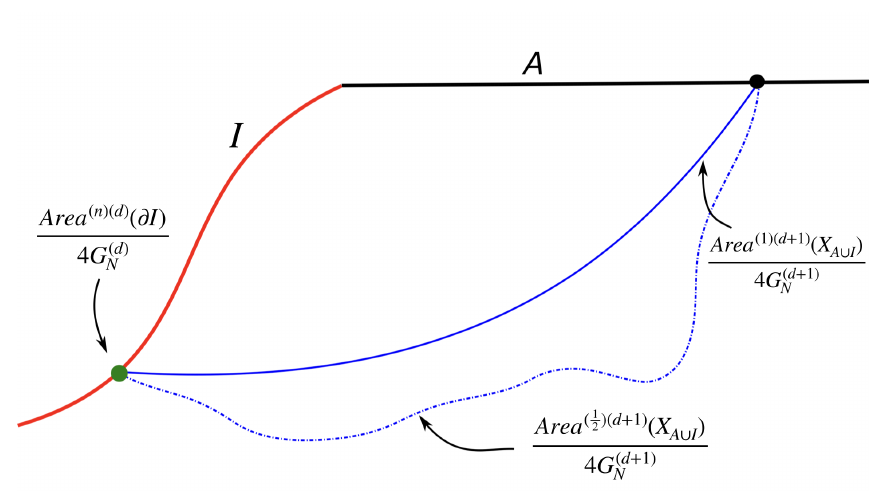
Figure 26: Schematic for double holography picture of our proposal-I. Note that the superscript in the first bracket in the area terms denotes the Renyi index, and the one in the second bracket indicates the dimension of the spacetime in which the surface is